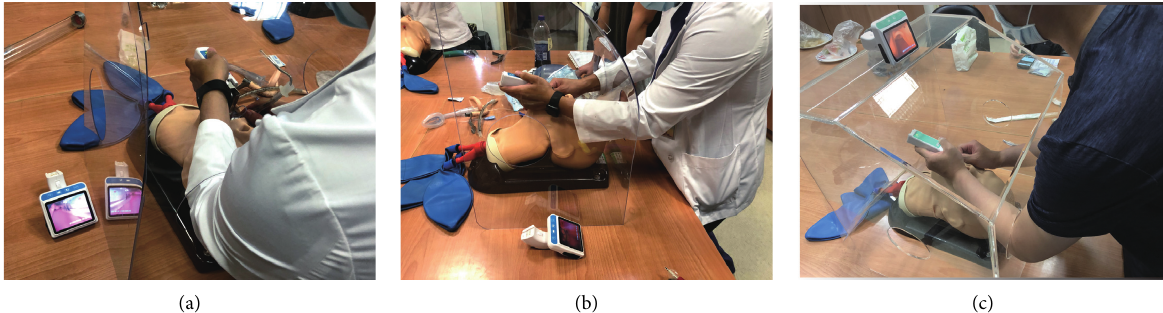
Figure 4: (a) Trachway with a stylet or video laryngoscope is more effective to prevent contamination wirelessly. (b, c) Trachway system intubation is suitable to different acrylic protective